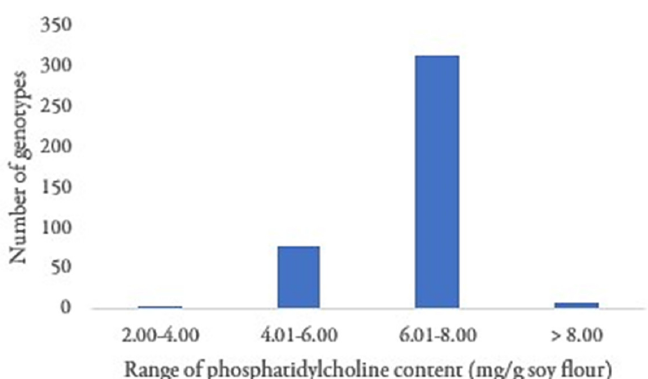
Figure 2. Distribution of 408 soybean genotypes according to phosphatidylcholine